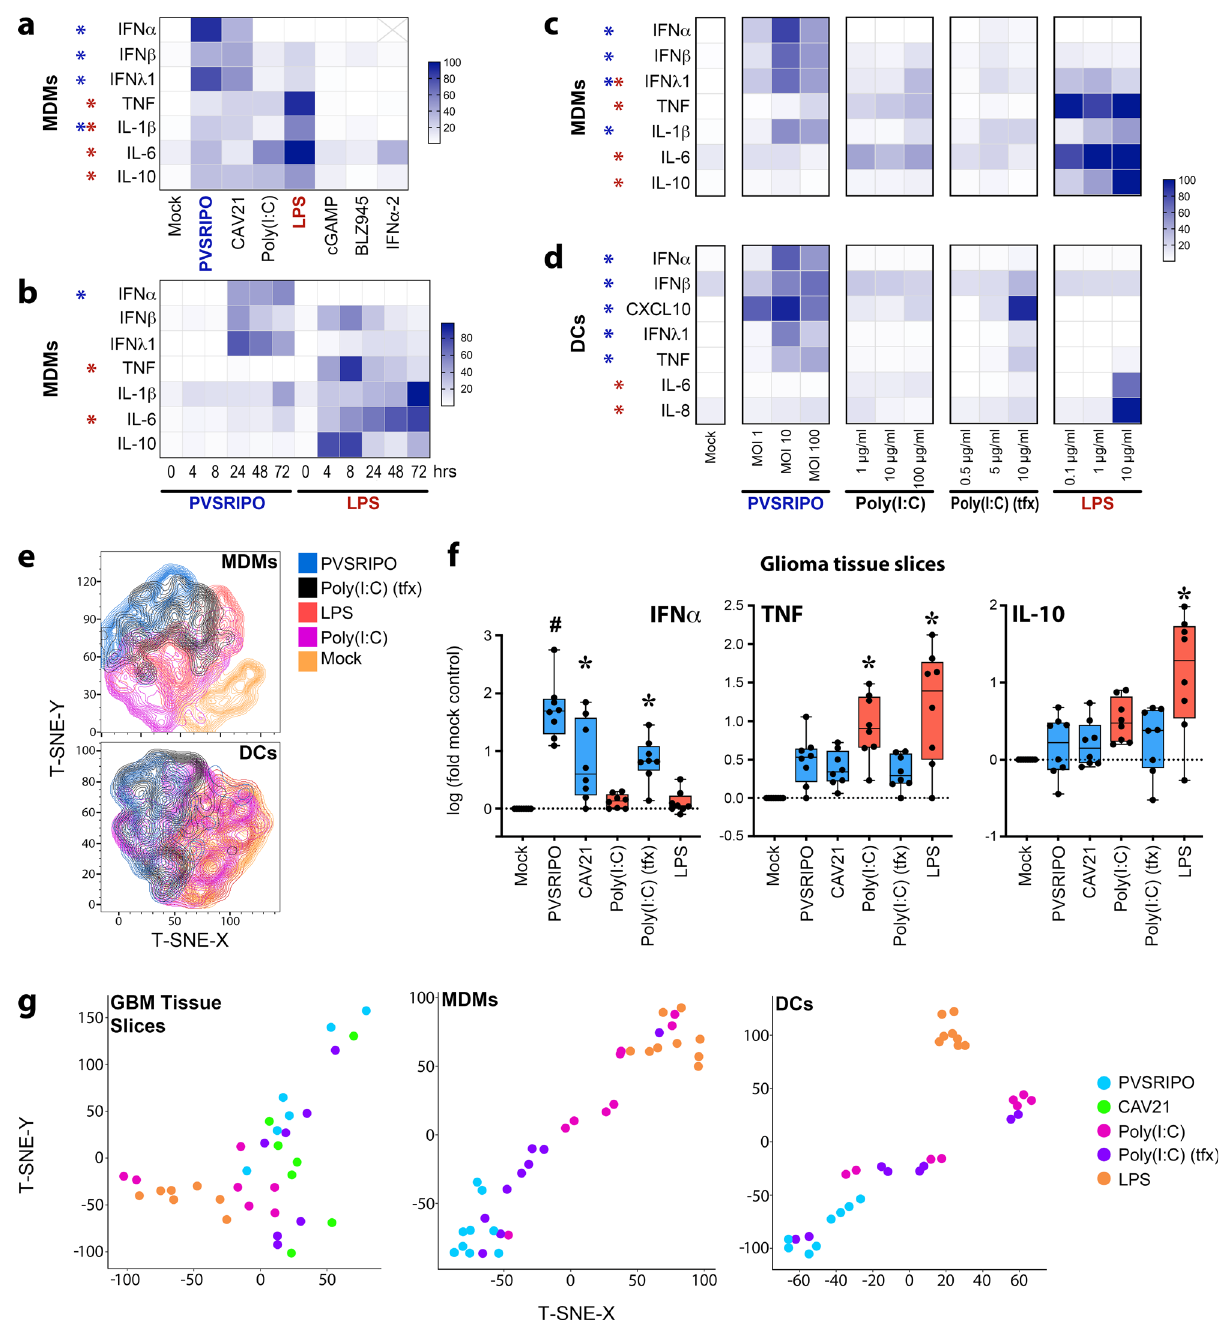
Fig. 4 Cytoplasmic dsRNA induces a distinct innate immune activation pro fi le. a Monocyte-derived macrophages (MDMs) were treated with putative macrophage activators [PVSRIPO/CAV21, MOI 10; Poly(I:C)/LPS/cGAMP (as in Fig. 1a); BLZ945, 50 nM; IFN α 2, 200 IU/ml] for 48 h; cytokine release was measured. Maximum cytokine concentration (pg/ml) was set to 100% for each cytokine; n = 7 experiments from three donors; IFN α values omitted for IFN α 2 treatment. b Cytokine release after MDM treatment time course with PVSRIPO or LPS normalized as in ( a ); n = 5 experiments from 3 donors. (*) signi fi cant paired t-test comparing sums of PVSRIPO (blue) vs LPS (red) normalized (%max) values for all time points for each cytokine ( p < 0.05, two- tailed; IFN α p = 0.009, TNF p = 0.005, IL-6 p = 0.0007). c , d Supernatant cytokines were measured 48 h after treatment of MDMs ( c ) or monocyte- derived DCs ( d ) with escalating doses of stimuli as shown; n = 4 experiments from 2 donors; normalized as in ( a ). a , c , d (* ) indicates Dunnett ’ s post-hoc test p < 0.05, two tailed, vs mock ( a ). c , d asterisks are shown if p < 0.05 at any dose. a – d Only treatment-induced cytokines are shown; asterisk color indicates signi fi cance for LPS (red) or PVSRIPO (blue); see Supplementary Figs. 6 and 7 for extended analyses and gating. e T-SNE plot based on surface activation marker staining after indicated treatments as shown for MDMs (top panel) or DCs (bottom panel). f Ex vivo treatment (48 h) of GBM slices was performed for denoted stimulants [PVSRIPO/CAV21 1 × 10 8 pfu; Poly(I:C)-tfx 2.5 μ g/ml, Poly(I:C) 10 μ g/ml, LPS 100 ng/ml], released cytokine concentration (pg/ml) was analyzed and normalized to log-fold-mock control for each cytokine ( n = 8); box represents quartiles + median and whiskers indicate range; Tukey ’ s post-hoc test p < 0.05 (two-tailed) vs mock treatment (*) or all groups (#). g T-SNE plots using fold-mock cytokine values after each treatment for GBM tissue slice culture assay ( f ), MDMs ( c , middle doses), or DCs ( d , middle doses).